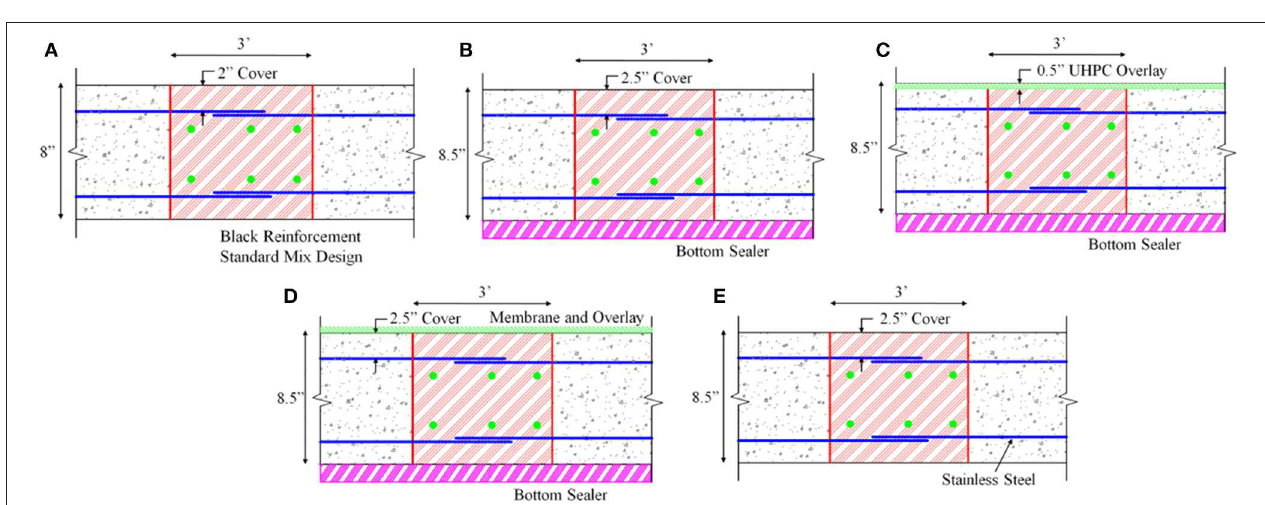
Frontiers in Built Environment |